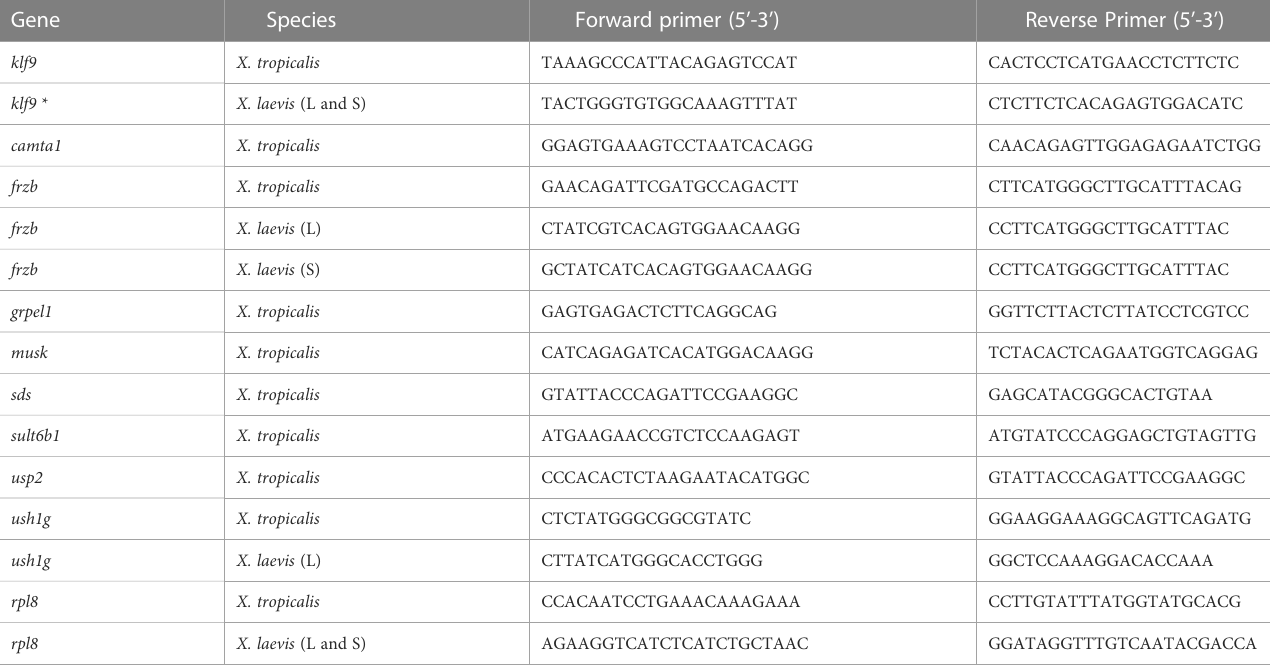
TABLE 1 Primer and probe sequences of genes studied using quantitative PCR.